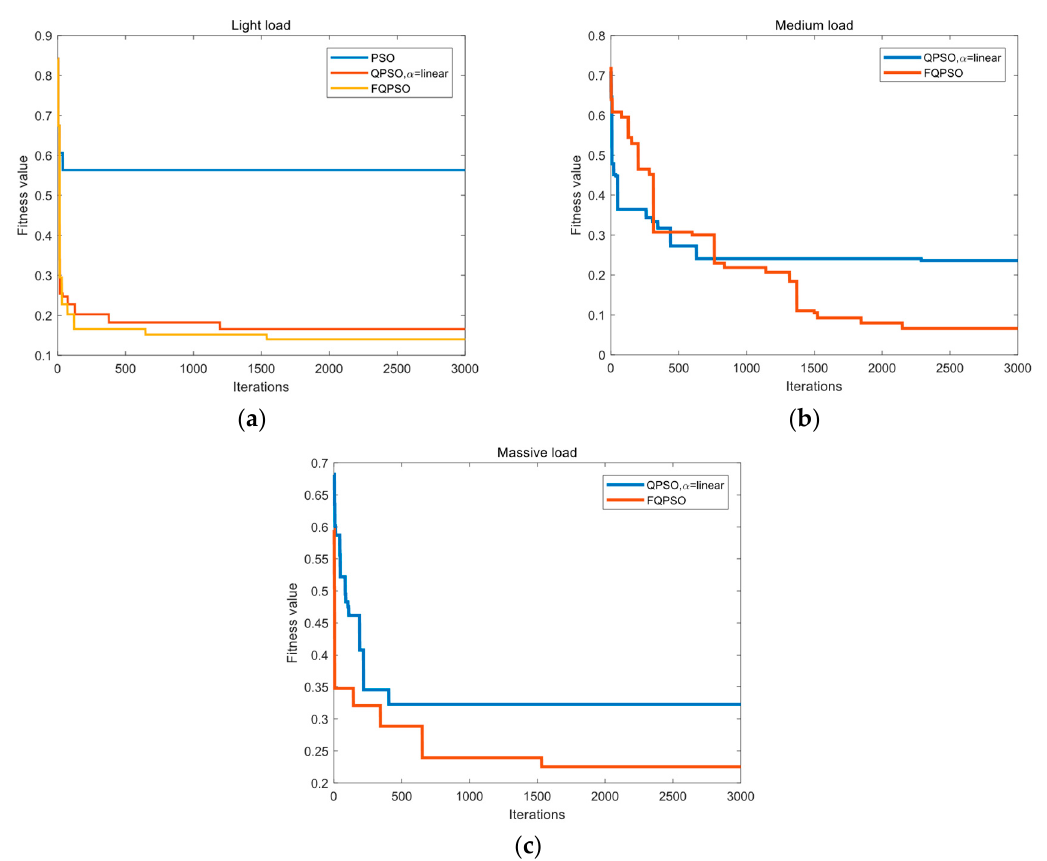
Figure 7. Convergence results of particle swarm optimization (PSO), quantum-behaved particle swarm optimization (QPSO), and fuzzy-controlled quantum-behaved particle swarm optimization (FQPSO) algorithms in ( a ) light load, ( b ) medium load and ( c ) massive load.